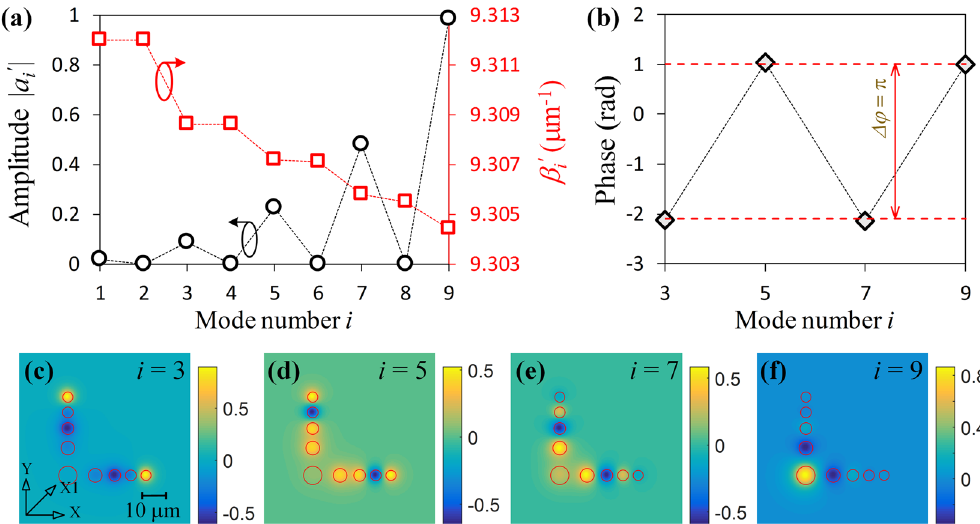
and the propagation coefficient i